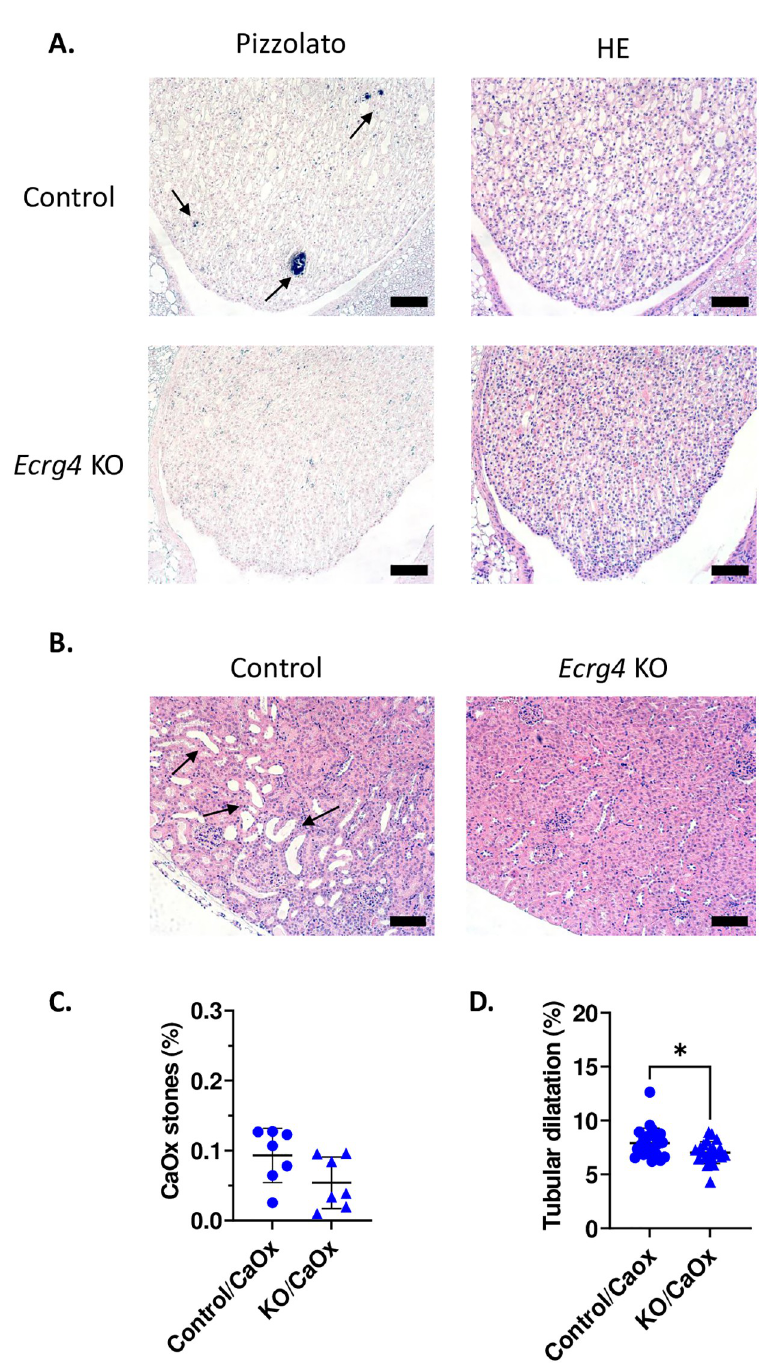
Fig 4. Ecrg4 KO male mice have less renal tubular obstruction after 8 days of CaOx diet. (A) Representative pictures of renal papilla stained by Pizzolato (left panels) or Hematoxylin-eosin (HE, right panels) at 20x magnification. Intraluminal crystals and tubular dilation are visible in control mice but not in Ecrg4 KO mice. Bars represent 100um. (B) HE staining of sections of the cortex of kidneys from control and Ecrg4 KO male mice kidneys, after 8 days of CaOx diet, at 20x magnification. Bars represent 100um. The black arrows indicate the intraluminal crystals (A), as well as the tubular dilatation (B) in the control mice. (C) Quantification of the CaOx crystals in kidney tissue expressed as percentage of crystal surface over the kidney section (n = 7). (D) Quantification of tubular dilation of the cortex expressed as percentage of surface dilated over the whole surface (5 sections/mouse; n = 7). Data are shown individually and as mean ± SD. P values are calculated using